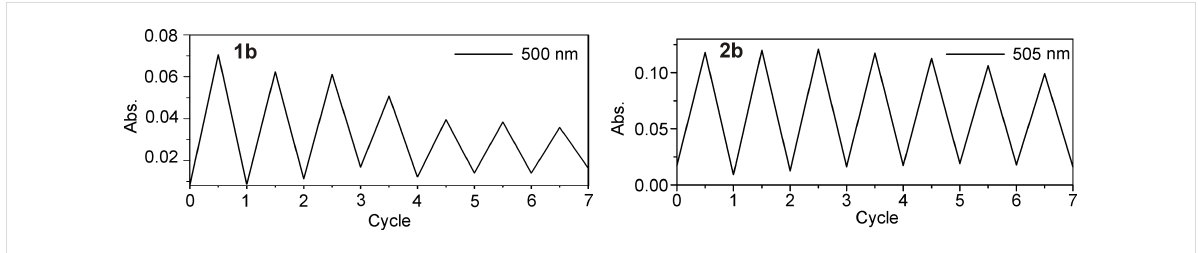
Figure 3: Reversibility measurements of deazaadenosine photoswitches with one and two methyl groups. A 60 µM solution of the compound in aceto- nitrile was irradiated with UV light until the (pseudo-)photostationary state was reached. After recording the UV–vis spectrum, the solution was irradi- ated with vis light for the same time. This procedure was repeated 7